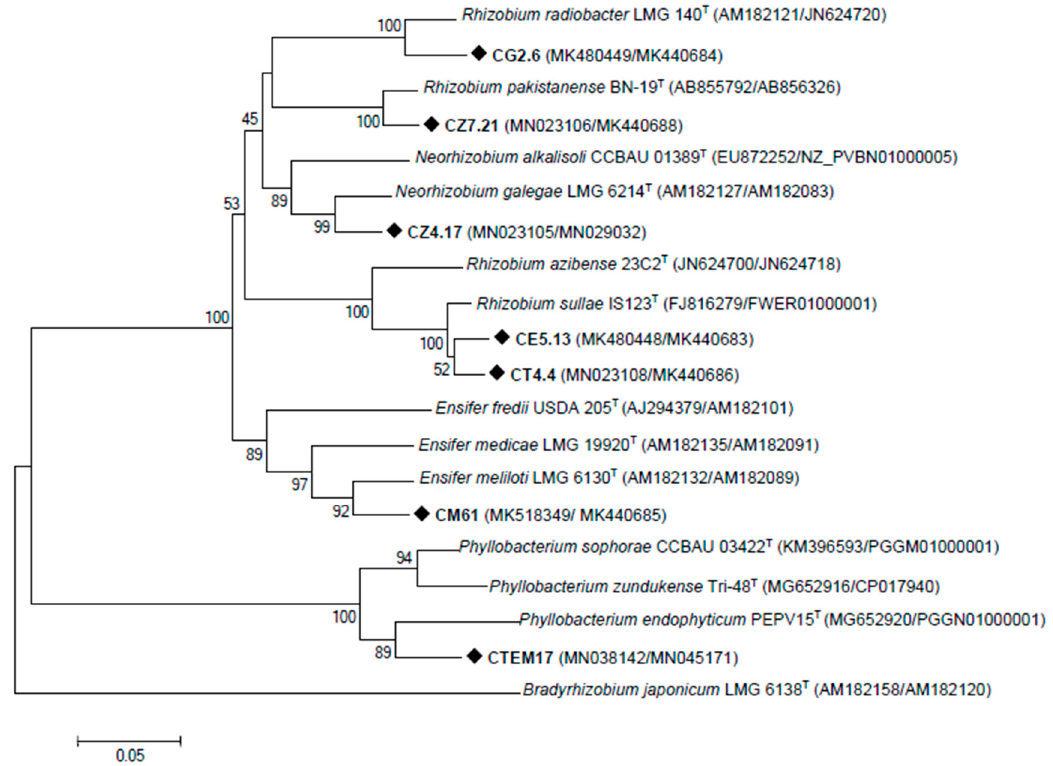
Figure 2. Neighbour-joining tree based on concatenated recA and dnaK gene sequences of representative nodule-inducing strains isolated from nodules of Calicotome villosa . The significance of each branch is indicated by the bootstrap value calculated for 1000 replicates (only values higher than 75% are indicated). Scale bar = 0.02 nucleotide divergence.